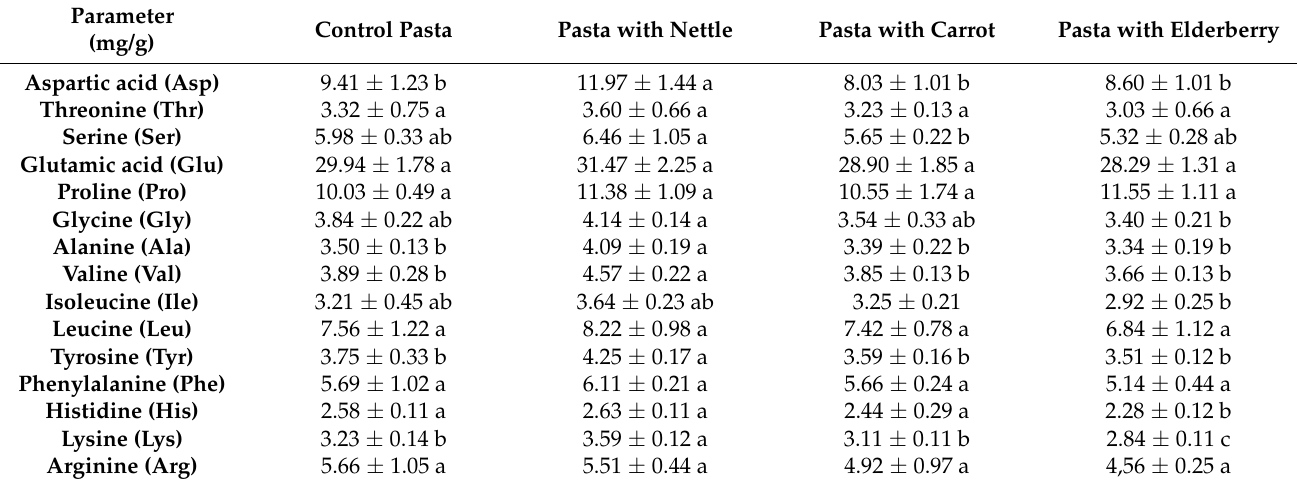
Table 2. Selected amino acid composition in prepared pasta.